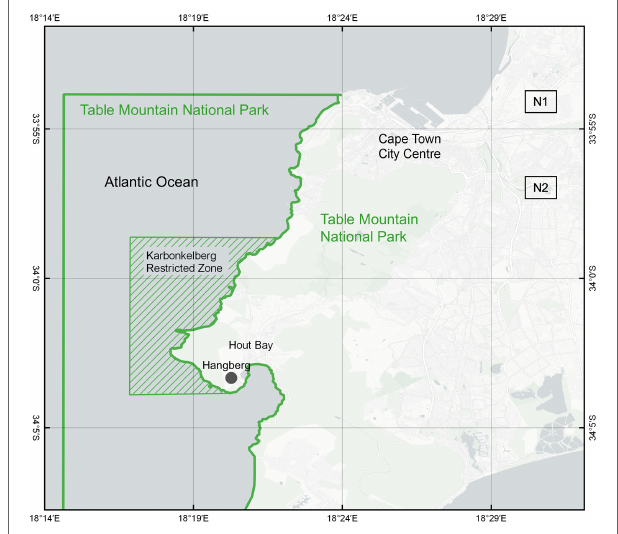
FIGURE 2 | The Karbonkelberg Reserve is a restricted zone (green dashed box) situated within the Table Mountain National Park (green border). This national park borders the city of Cape Town